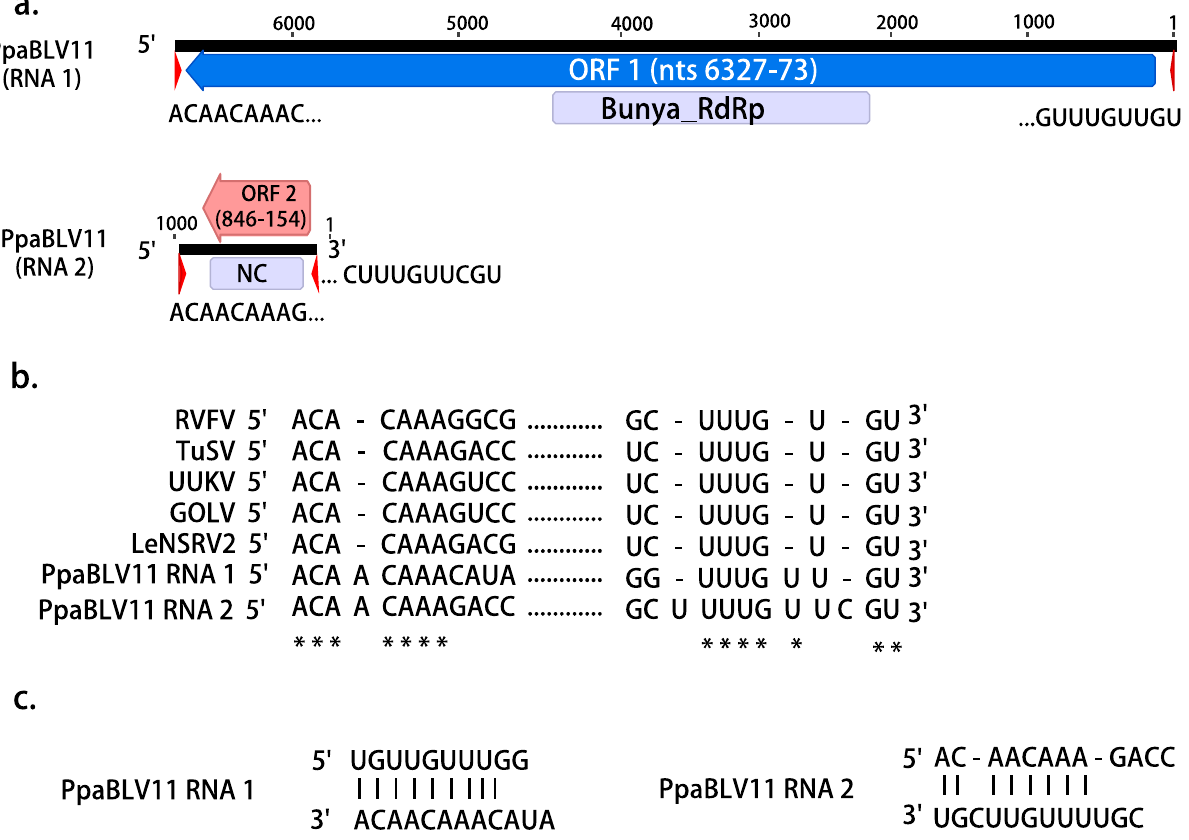
Figure 1. ( a ). Graphical representation of the L segment (RNA 1) and S segment (RNA 2) of PpaBLV11. ( b ). Alignment of 5 ′ and 3 ′ terminal sequences of PpaBLV11 RNA1 and RNA 2 with RNA1 or L segment sequences from the following viruses: Rift Valley fever virus (RVFV, DDBJ/EMBL/GenBank accession number: X56464), tulip streak virus (TuSV, LC571987), Uukuniemi virus (UUKV, D10759), Gouleako virus (GOLV, HQ541738), Lentinula edodes negative-strand RNA virus 2-HG3 (LeNSRV2, LC466007). Asterisks indicate that the nucleotides are 100% identical in all the viruses. ( c ). Complementary structure between the 3 ′ and 5 ′ termini in the putative PpaBLV11 genome.